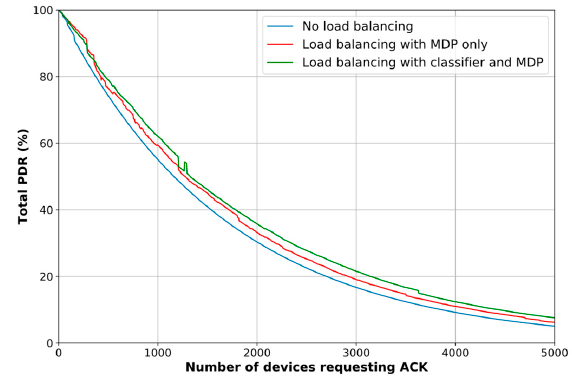
Figure 9. Network PDR improvement based on proposed scheme.